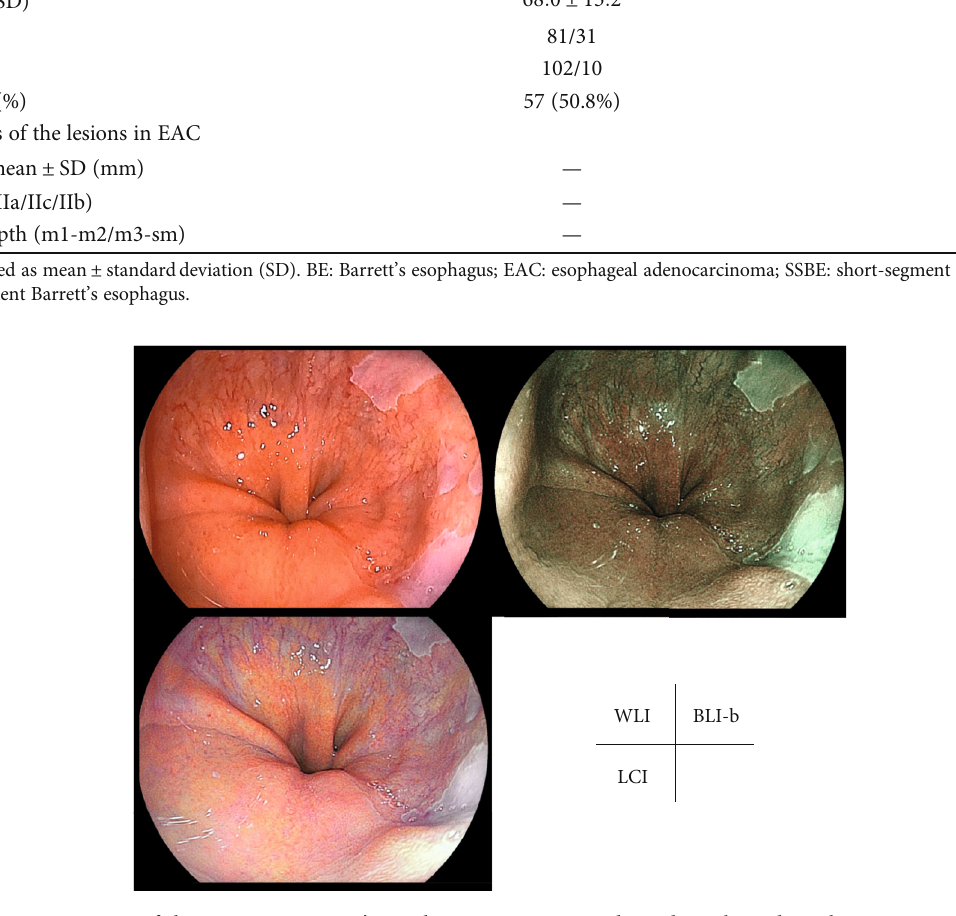
Figure 1: Representative case of short-segment Barrett ’ s esophagus. WLI, LCI mode, and BLI-b mode at the same site in a fully extended condition without zooming. WLI: white light imaging; LCI: linked color imaging; BLI-b: blue laser imaging